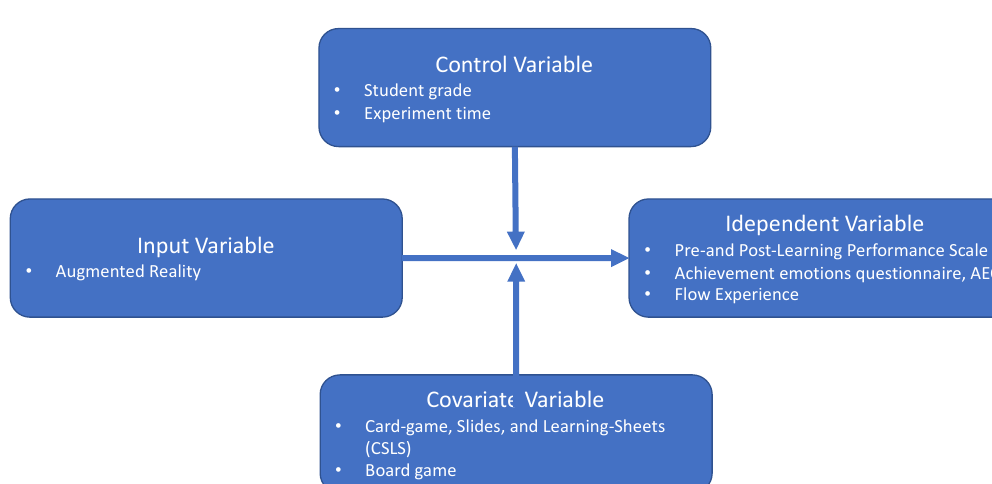
Figure 3. The research conceptual framework.